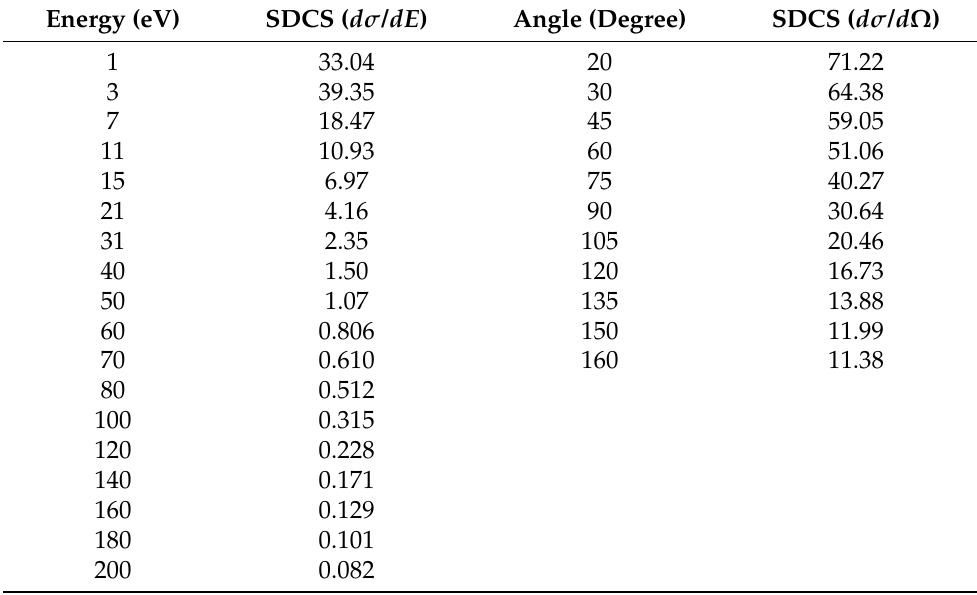
Table 3. Energy and angular distributions of SDCS in units of 10 − 18 cm 2 eV − 1 and 10 − 18 cm 2 sr − 1 , respectively (uncertainty ∼ 17%).